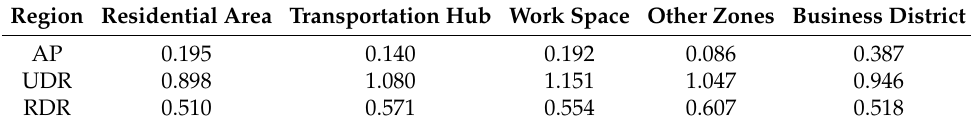
Table 1. Assessment results of functional